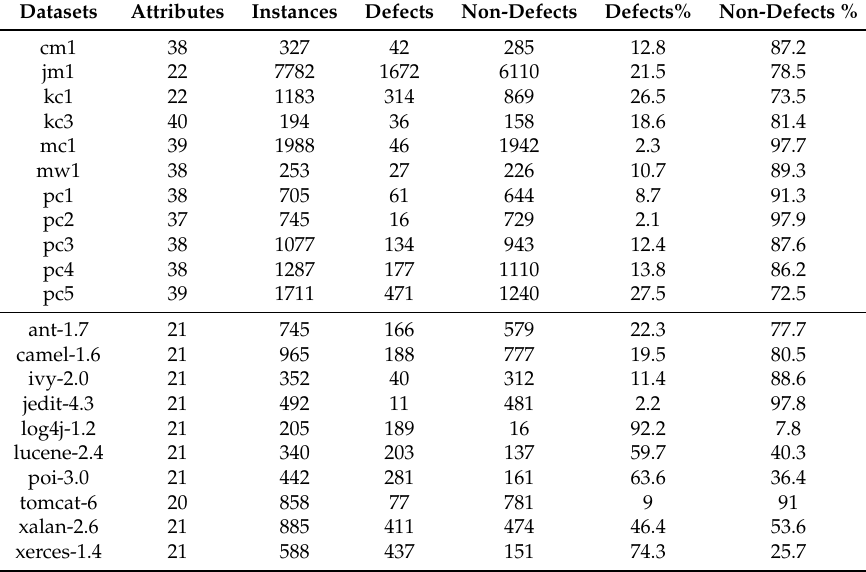
Table 2. Datasets